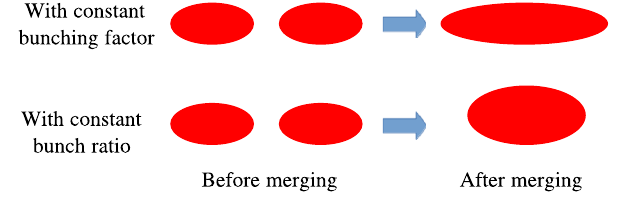
FIG. 3. Comparison of bunch merging with a constant bunch- ing factor (upper) and with a constant bunch ratio (lower).